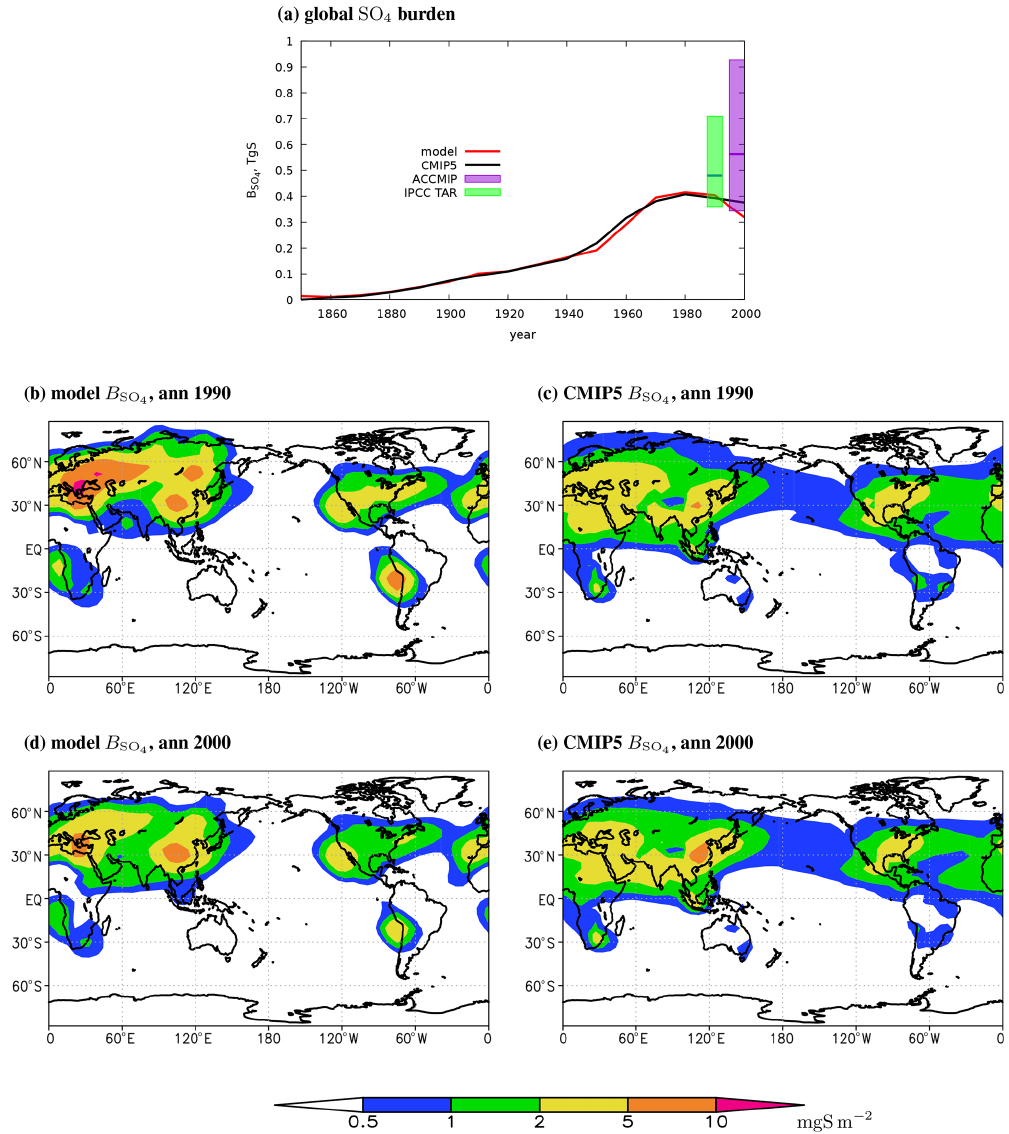
Figure 5. The globally and annually averaged modelled SO 4 mass in the atmosphere (a) and annual mean burdens per unit area (b–e) in the model (b, d) and in the CMIP5 database (c, e) in the years 1990 (b, c) and 2000 (d, e) . In (a) , horizontal lines on the colour boxes depict corresponding medians. The ACCMIP data are taken from Myhre et al. (2013, their Table 4). The IPCC TAR data are adopted from their Table 5.5 and are emission-rescaled (see the caption of Table